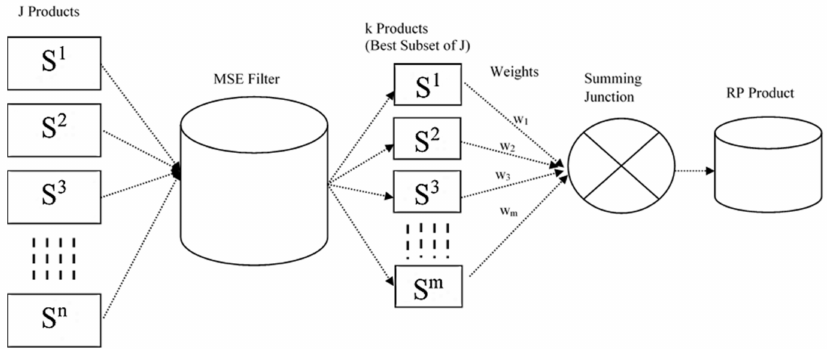
Figure 2. Flow diagram of the projected algorithm for the regional satellite precipitation estimate